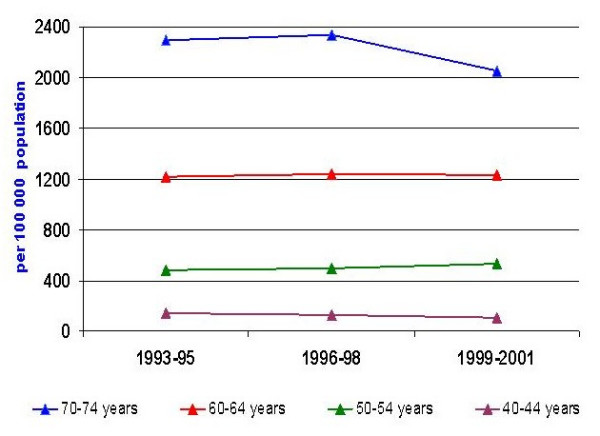
Trend in age-group specific cancer incidence among men in Arkhangelskaja Oblast, all sites combined.